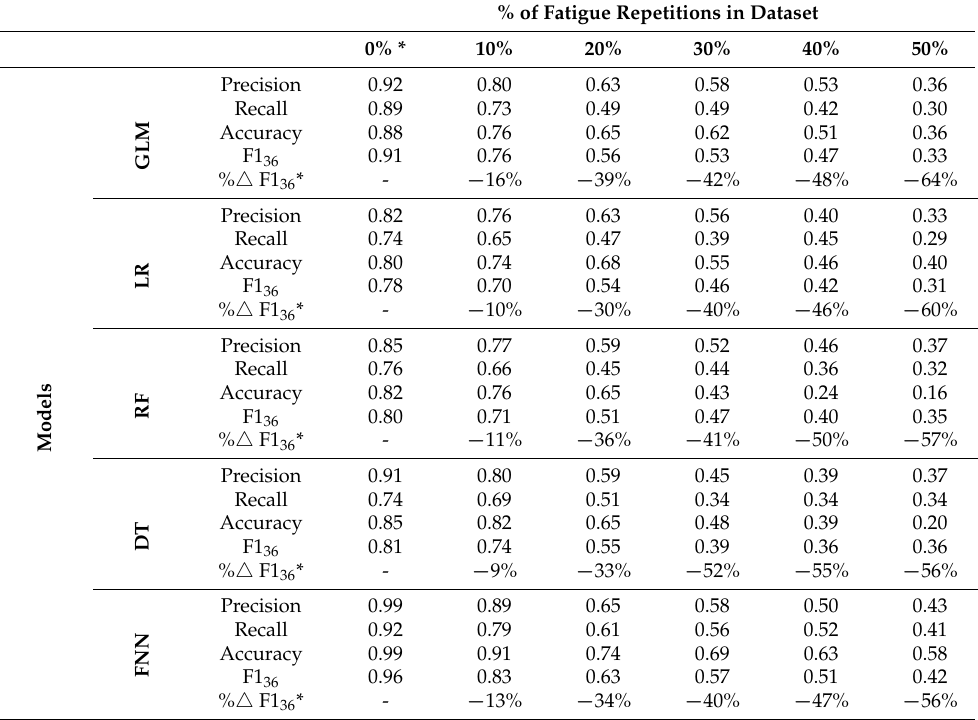
Table 10. The performance averages for cross-subject models to detect biceps repetitions, using the 36 features, throughout the incremental replacement of fatigue